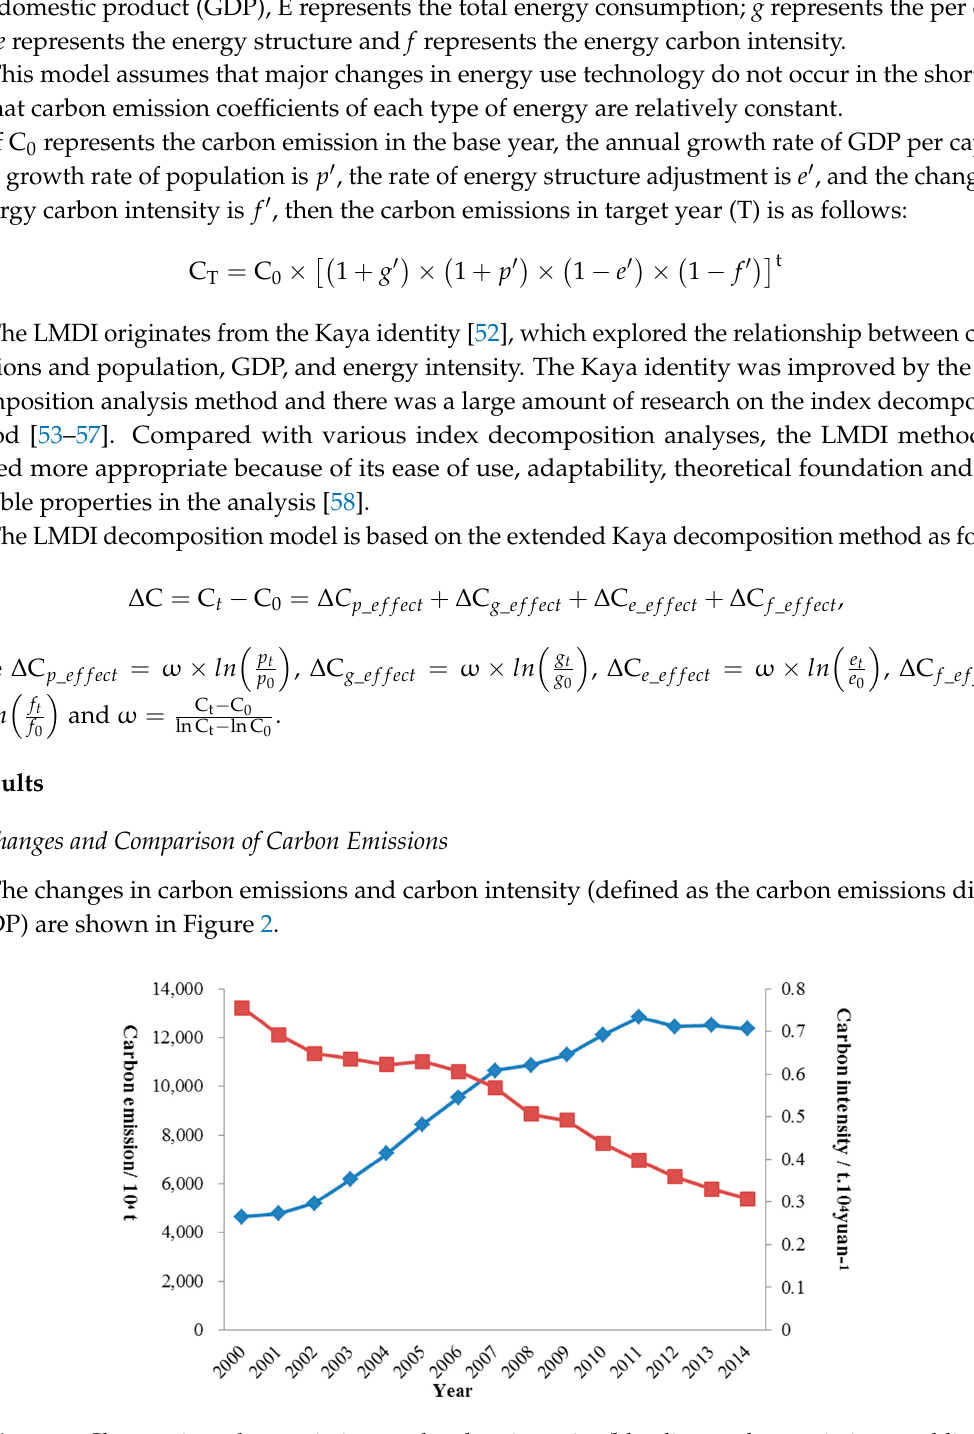
Figure 2. Changes in carbon emissions and carbon intensity (blue line: carbon emissions; red line: carbon intensity).